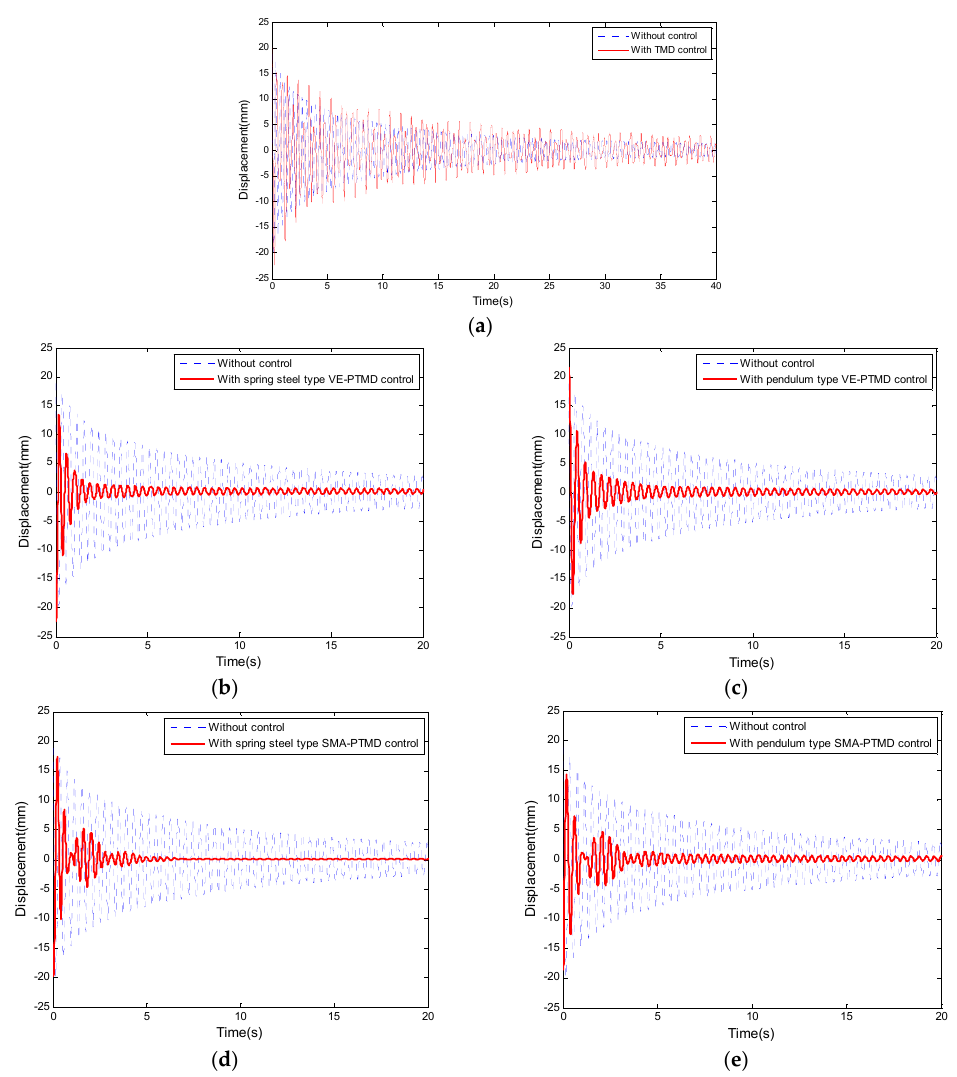
Figure 7. Experimental results of free vibration: ( a ) With tuned mass dampers (TMD); ( b ) with spring steel type VE–PTMD; ( c ) with pendulum type VE–PTMD; ( d ) with spring steel type SMA–PTMD; ( e ) with pendulum type SMA–PTMD.